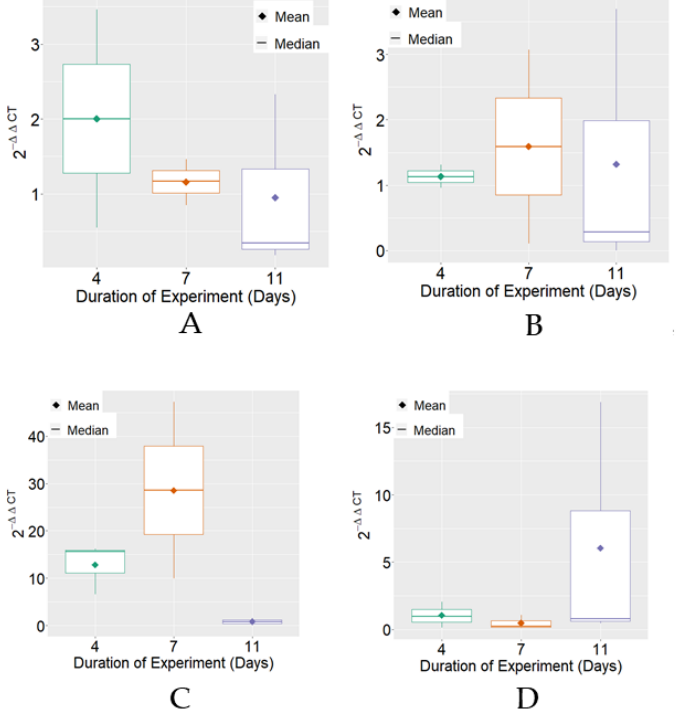
Figure 2. Boxplot of variable 2 − ∆∆ CT for HSP70 mRNA expression for each treatment. ( A ) Negative Control; ( B ) Positive Control; ( C ) BPF — basic protein feed; ( D ) FPP — protein feed with prebiotics and probiotics.